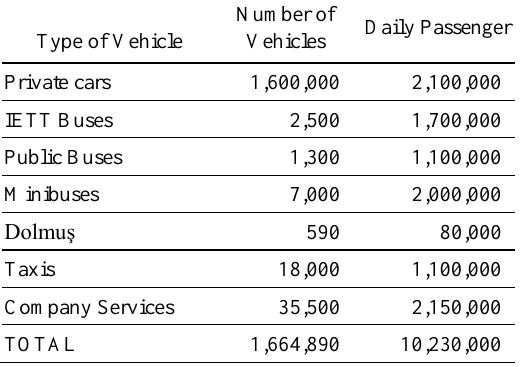
Type of Vehicle